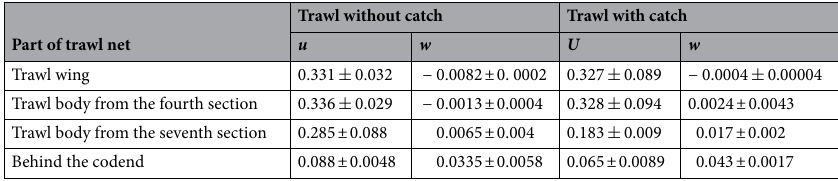
Table 2. Mean flow velocities of the two